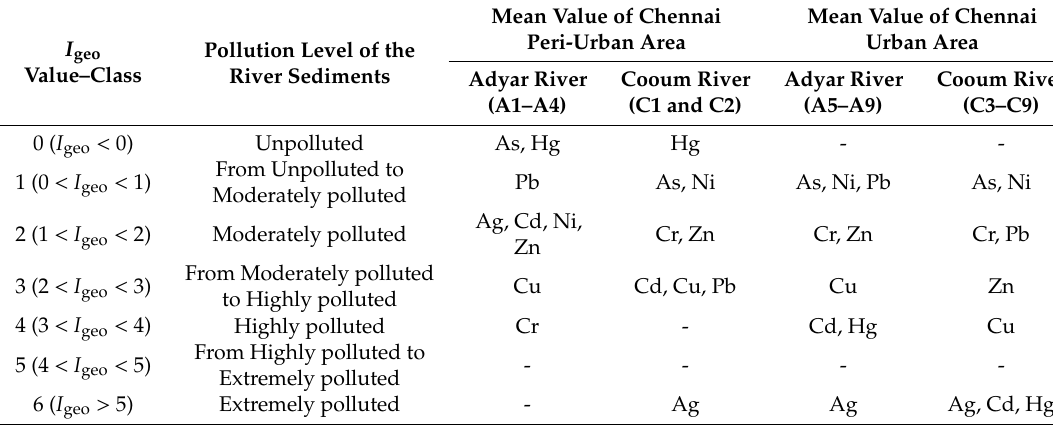
Table 2. Geoaccumulation Index ( I geo ) of trace elements in surface sediments for the Adyar and Cooum